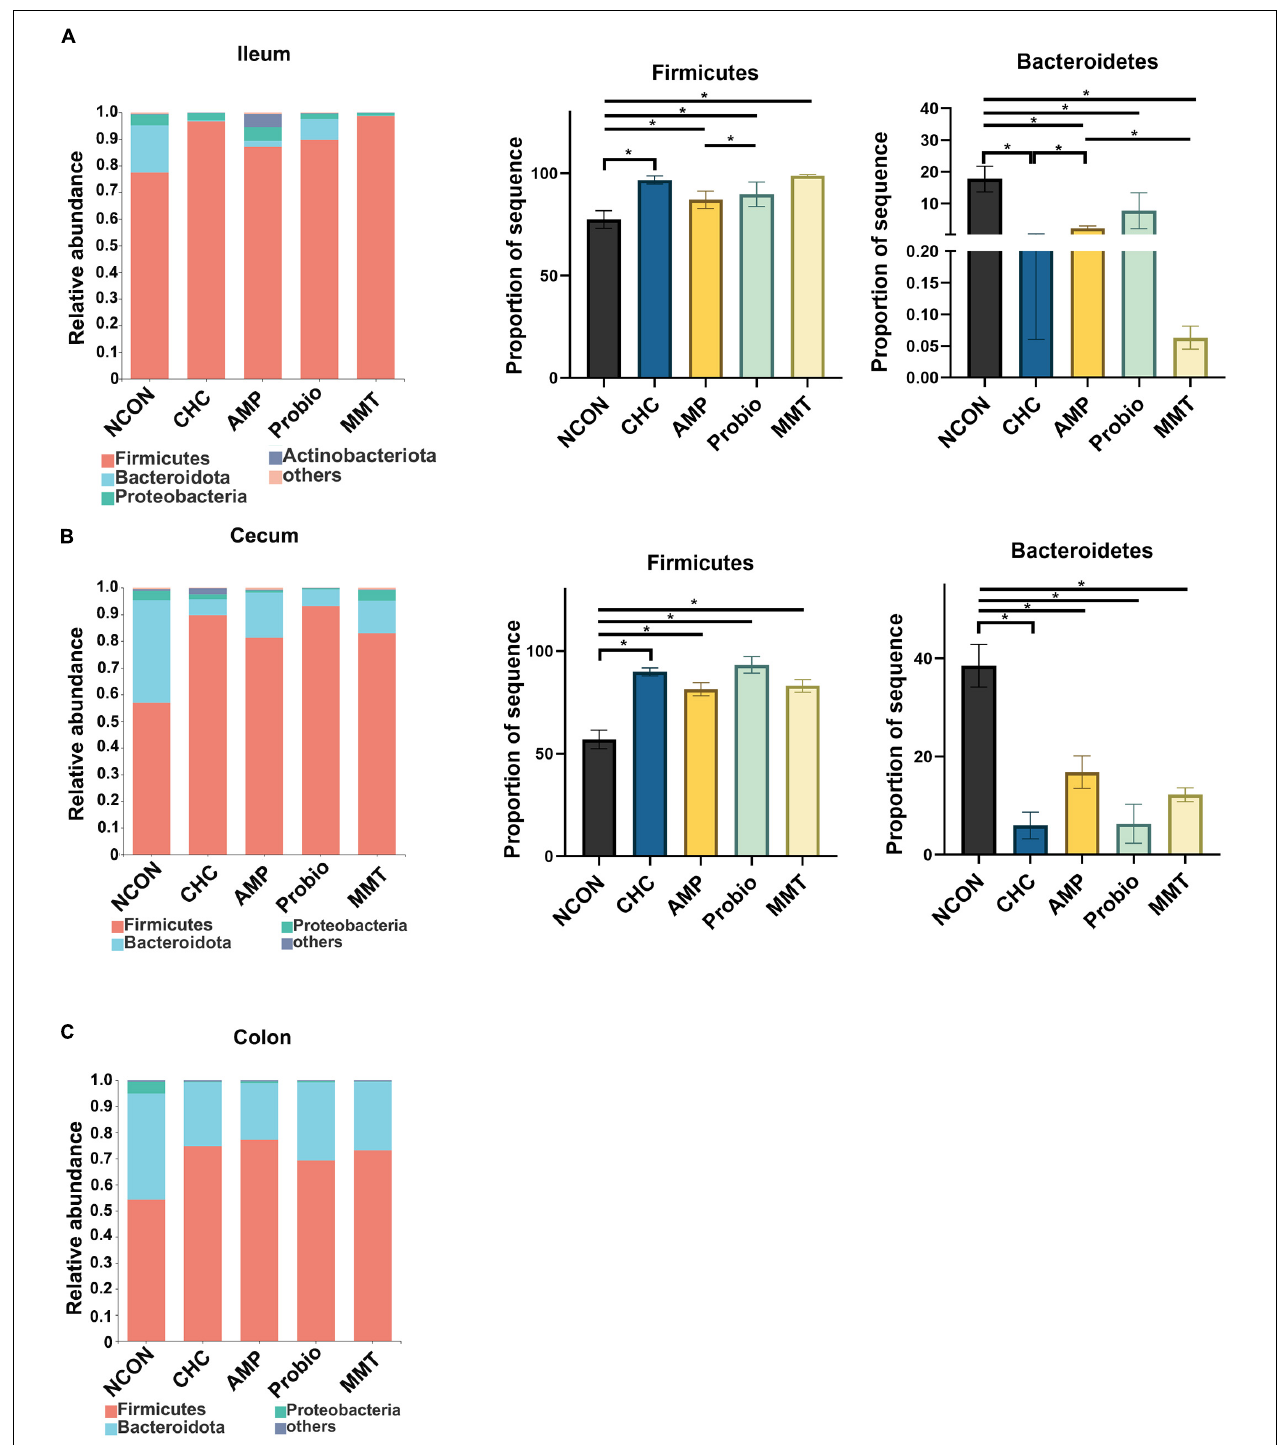
FIGURE 4 | Effects of dietary treatment on ileal, cecal, and colonic microbiota composition at the phylum level. (A) Ileal microbiota composition at the phylum level, and alterations of the abundance of bacterial phyla found in the ileum of broilers. (B) Cecal microbiota composition at the phylum level, and alterations of the abundance of bacterial phyla found in the cecum of broilers. (C) Colonic microbiota composition at the phylum level in broilers. NCON is a corn-soybean meal basal diets group. AMP is 200 mg/kg antibacterial peptide supplemented group. Probio is 200 mg/kg calsporin supplemented group. MMT is 500 mg/kg montmorillonite supplemented group. CHC is 500 mg/kg activated charcoal-herb extractum complex supplemented group. P values calculated using the ANCOM test and were adjusted by false discovery rate (FDR) correction according to the Benjamini-Hochberg procedure, and the level of significance was set at FDR < 0.10; * presented FDR < 0.10. Firmicutes (ileum), FDR = 0.031; Bacteroidetes (ileum), FDR = 0.022; Firmicutes (cecum), FDR = 0.014; Bacteroidetes (cecum), FDR = 0.014.